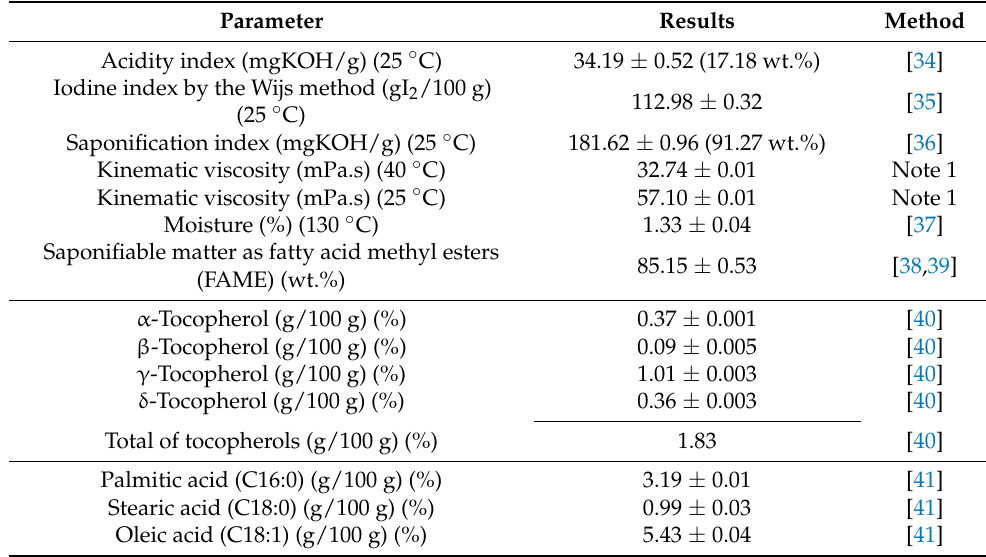
Table 1. Physicochemical properties of the soybean oil deodorizer distillate (SODD).